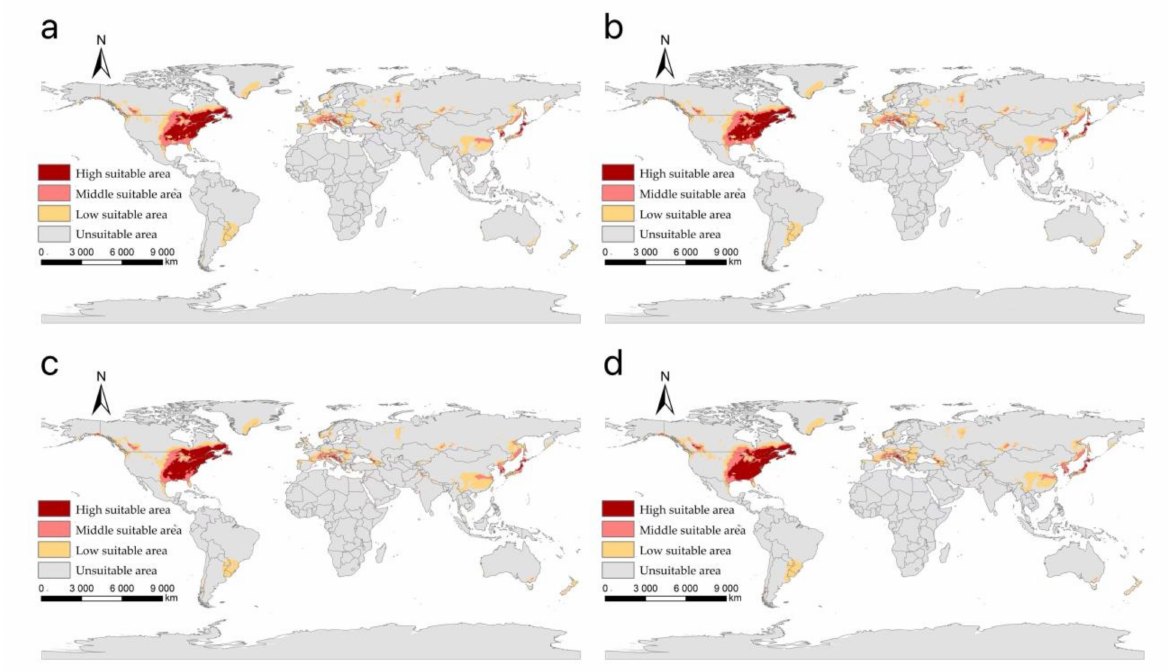
Figure 5. The suitable areas of I. scapularis around the world under shared socioeconomic pathway 2—4.5 (middle of the road and forcing of 4.5 W/m 2 to 2100) during different periods of the 21st century: ( a ) 2021–2040; ( b ) 2041–2060; ( c ) 2061–2080; ( d )